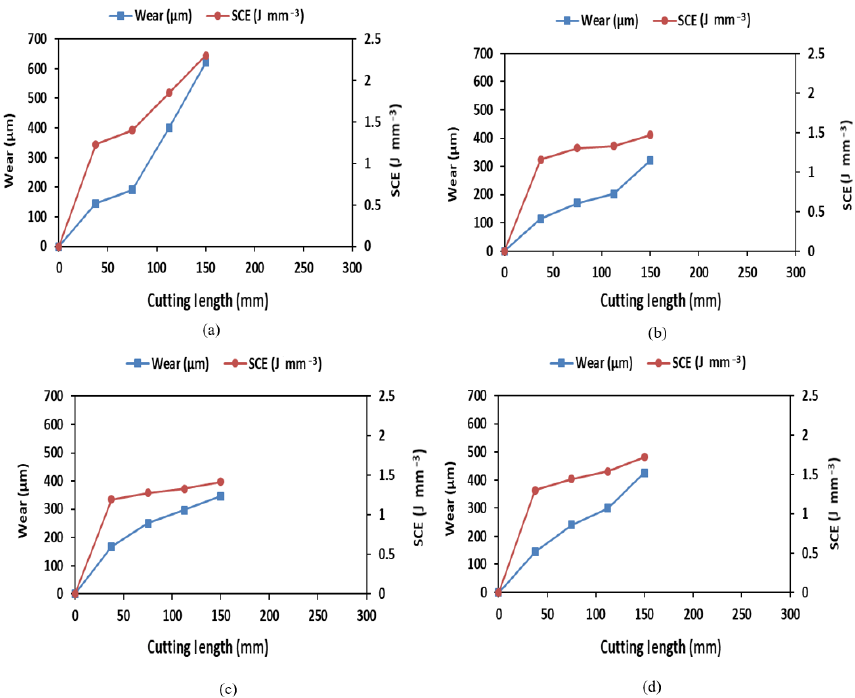
Figure 10. Variation in the SCE with the increase in the tool wear at different cutting lengths for (high wear region conditions); (a) Condition 1 ( V = 200mmin − 1 , f = 0 . 12mm per rev), (b) Condition 2 ( V = 125mmin − 1 , f = 0 . 24mm per rev), (c) Condition 4 ( V = 90mmin − 1 , f = 0 . 24mm per rev), (d) Condition 5 ( V = 75mmin − 1 , f = 0 . 16mm per